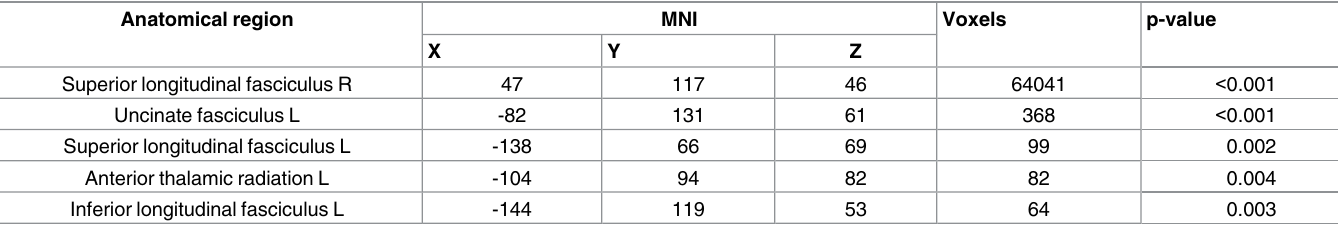
Table 2. Regions showing significant FA differences among NC, aMCI-s and aMCI-m based on ANCOVA. The clusters with a TFCE-corrected P- value of less than 0.01 and a minimum cluster size of 50 contiguousvoxels were reported. Anatomical